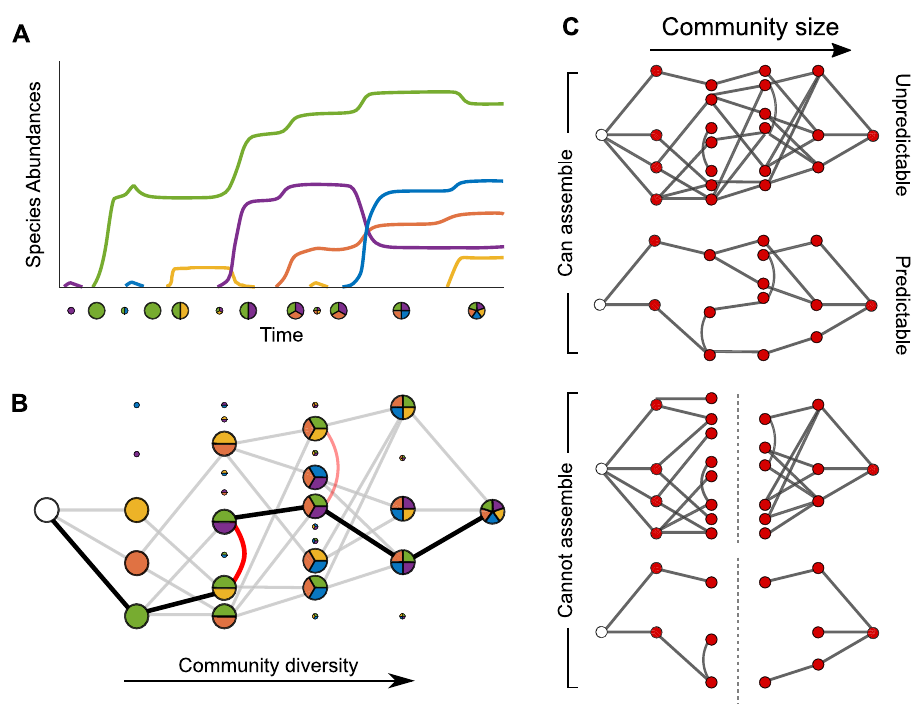
Fig 1. Mathematical models to simulate and map out community assembly. (A) One method of exploring community assembly is to draw species one by one at random from a large pool then assess whether and how they establish a diverse community. However, this approach only gives a single example of assembly per community, and due to the vast number of possibilities, we do not know whether other assembly pathways are possible. ( B) In our alternative approach, we randomly select a diverse community, then determine which of its subcommunities are feasible and all possible transitions between them. In this manner, we can map out all the pathways by which a given community may have assembled (bold line in B indicates assembly pathway observed in A ). ( C) Examining the characteristics of a community’s assembly map enables us to determine whether it will be able to assemble from scratch and whether it will assemble in a predictable